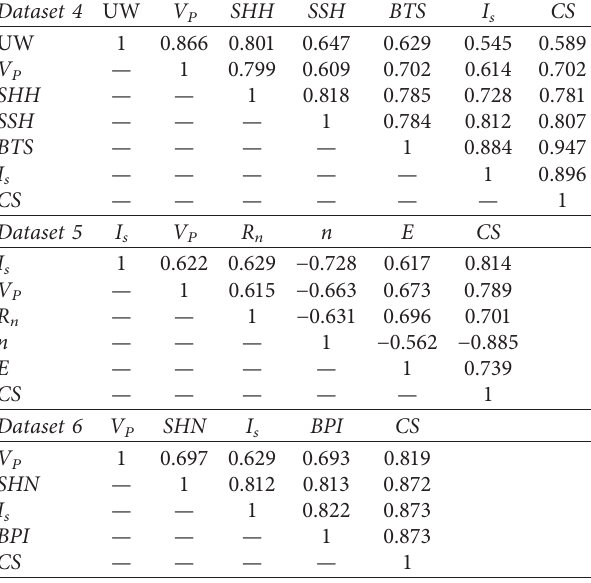
Table 4: Correlation matrices of rock datasets.